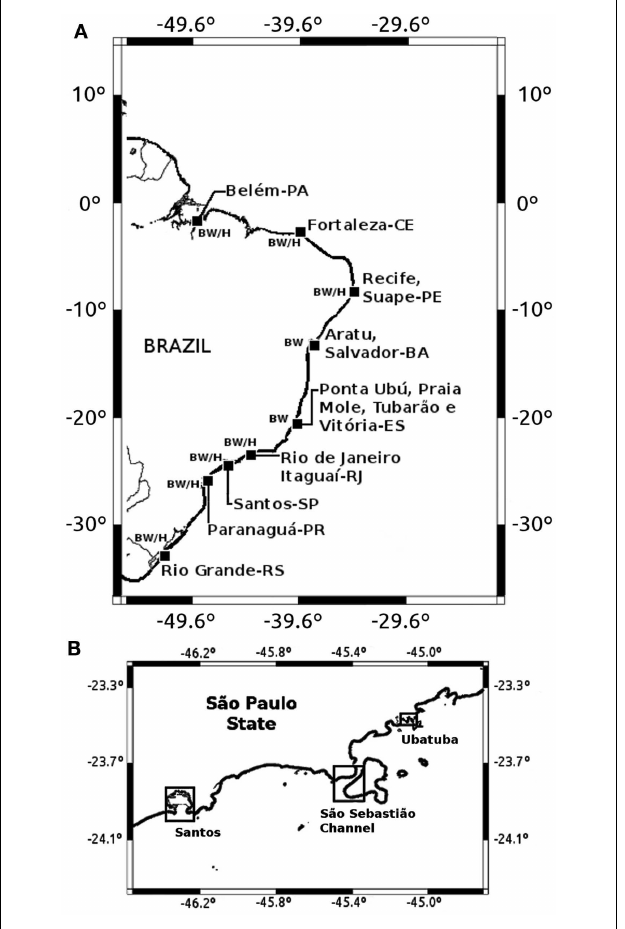
FIGURE 1 | Locations of ballast water (BW) and environmental (H) sampling sites in Brazilian ports (A) and in São Paulo State coastal areas